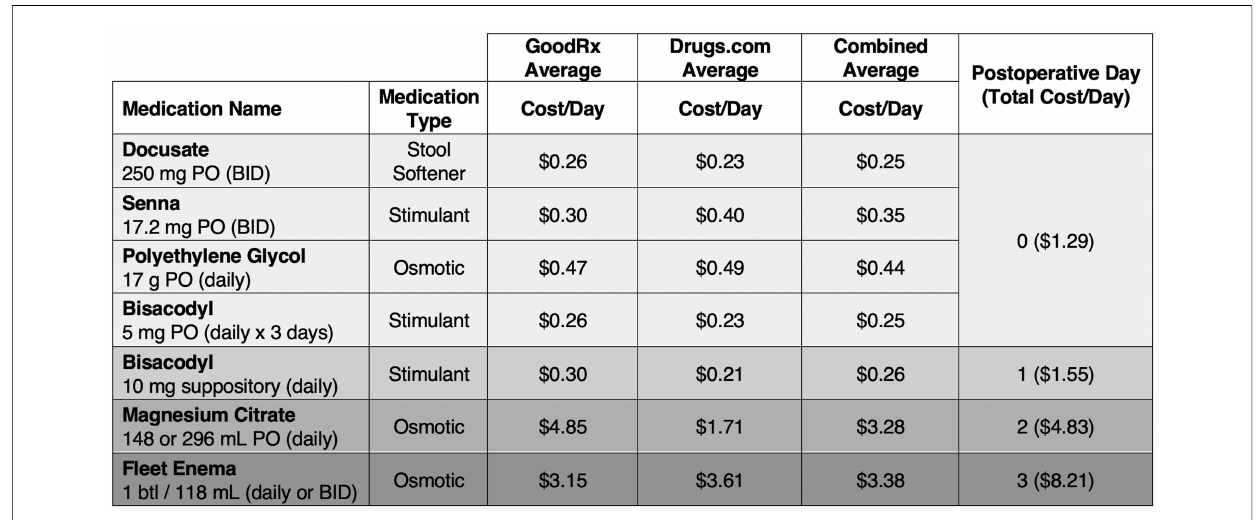
FIGURE 2 Estimated daily cost of postoperative bowel regimen protocol. Estimated costs of the standardized bowel regimen for each postoperative day were calculated using two widely utilized sources of medication pricing in the public domain: the Drugs.com database (https://www.drugs.com/price- guide/) and GoodRx (https://www.goodrx.com). $=United States dollar; BID=twice per day; btl=bottle; PO=per oral (by